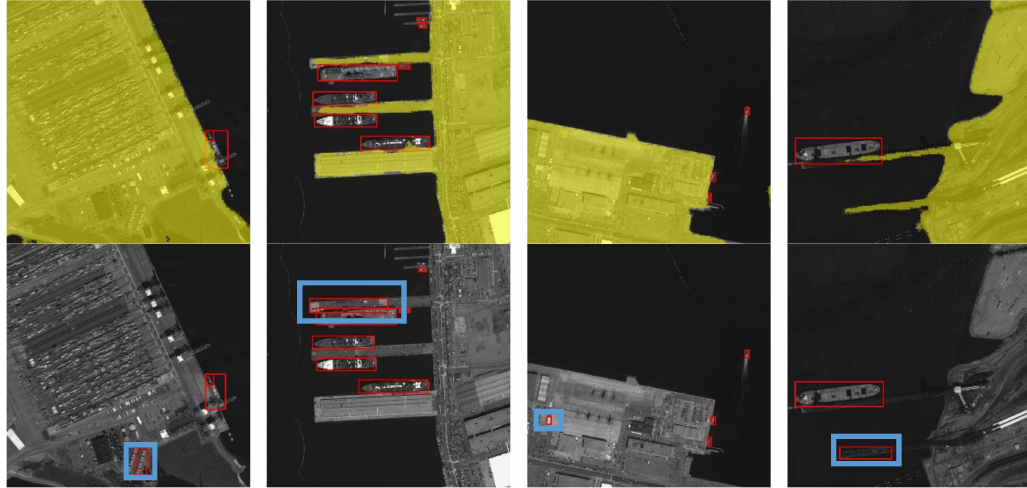
Figure 23. The ship detection result for the GF-2 panchromatic images by using the proposed method and Faster R-CNN, the first row is the result of our method and the second row is the result of the Faster